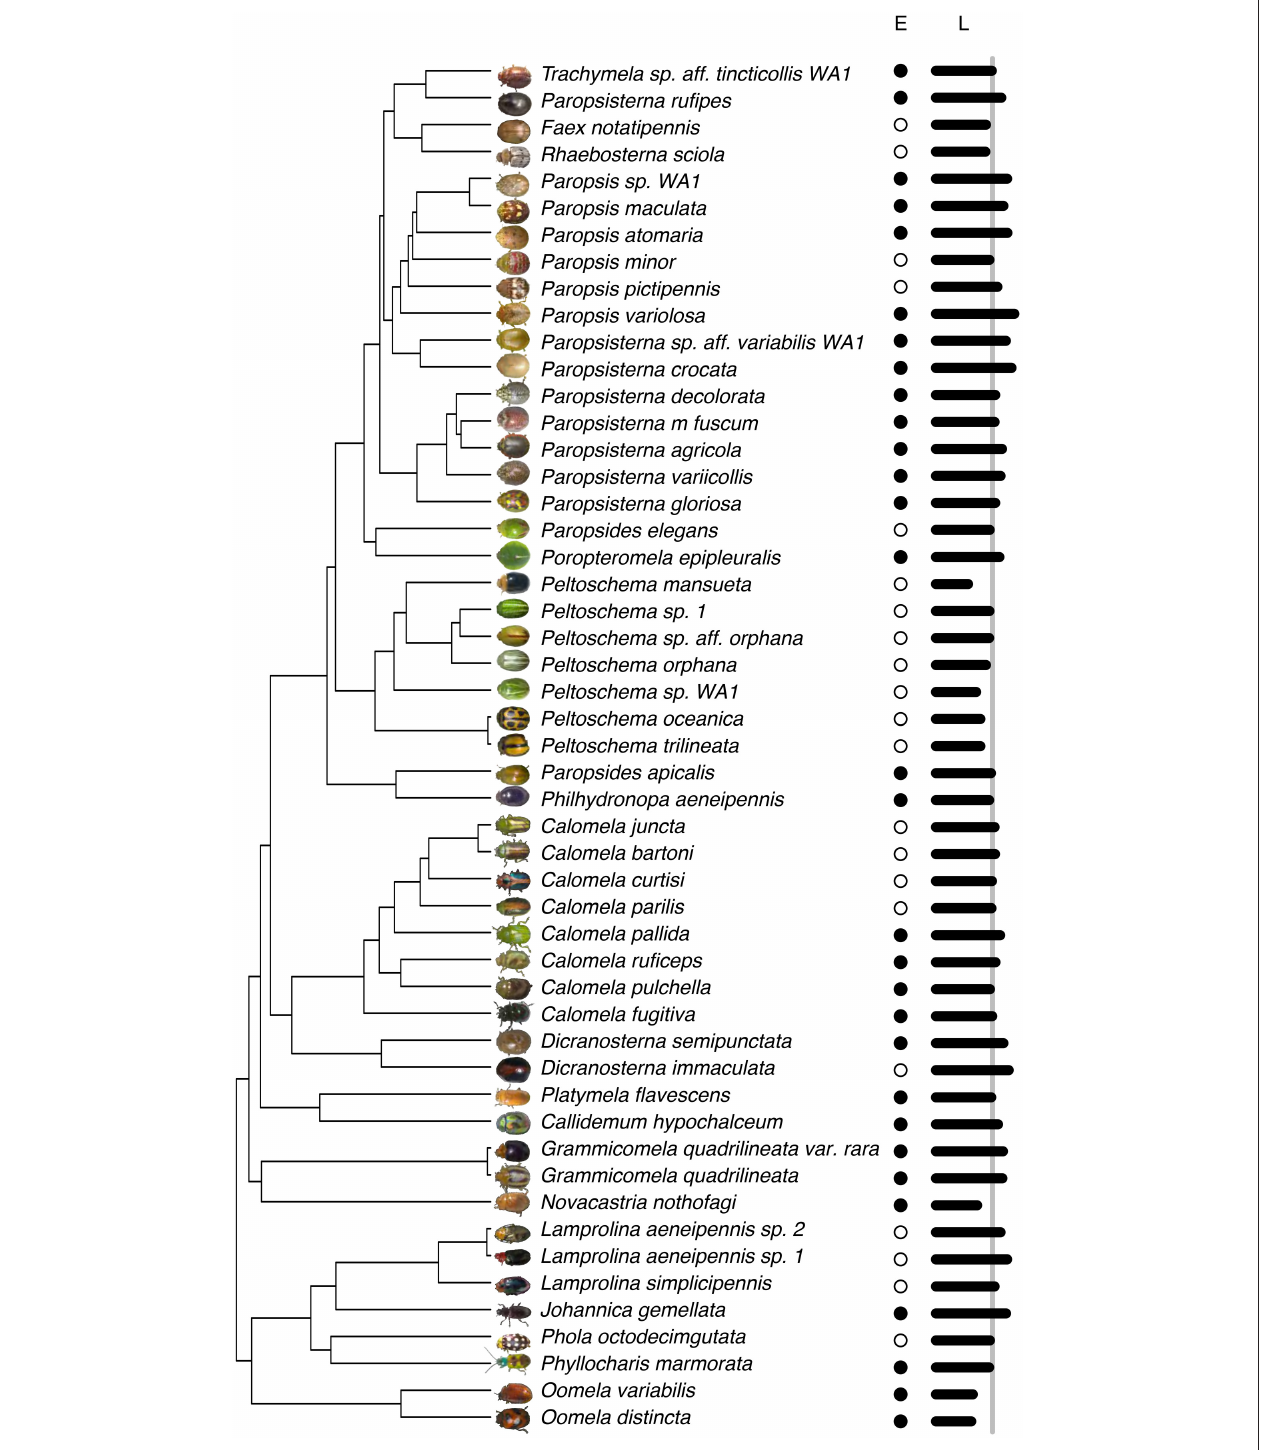
FIGURE 3 | Molecular phylogeny of chrysomelines. Corresponding beetle images (not to scale) are placed at the tips, before the species names. The light environment (E) is represented by open circles (light environments) or closed circles (dark environments). Beetle length (L) is represented by the horizontal lines adjacent to species names and the gray vertical line illustrates the average size of the chrysomelines.